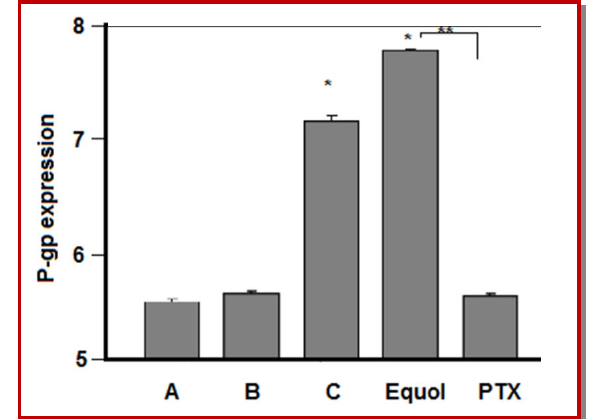
Figure 4 : P-gp expression in SKOV-3 cells. (A) control, (B) iso- type-matched negative control, (C) vinblastine-positive